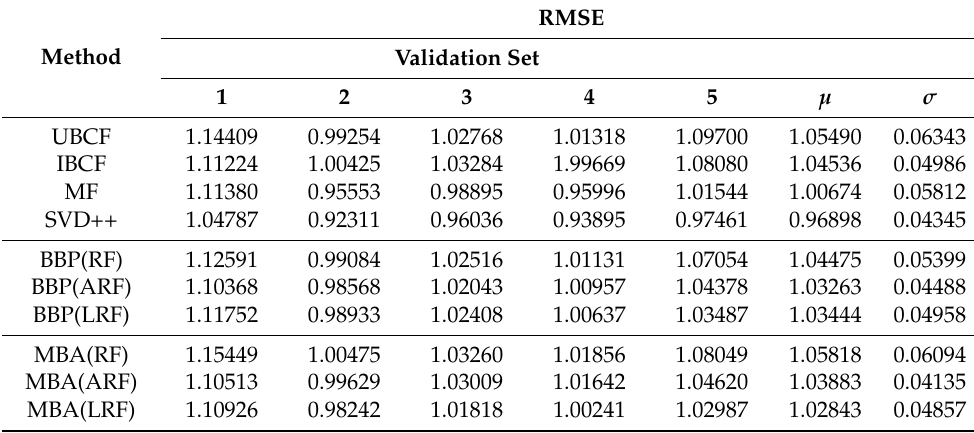
Table A1. For each method, 5-fold cross-validation was performed (1–5) and RMSE values are shown and their averages and variances are also shown.